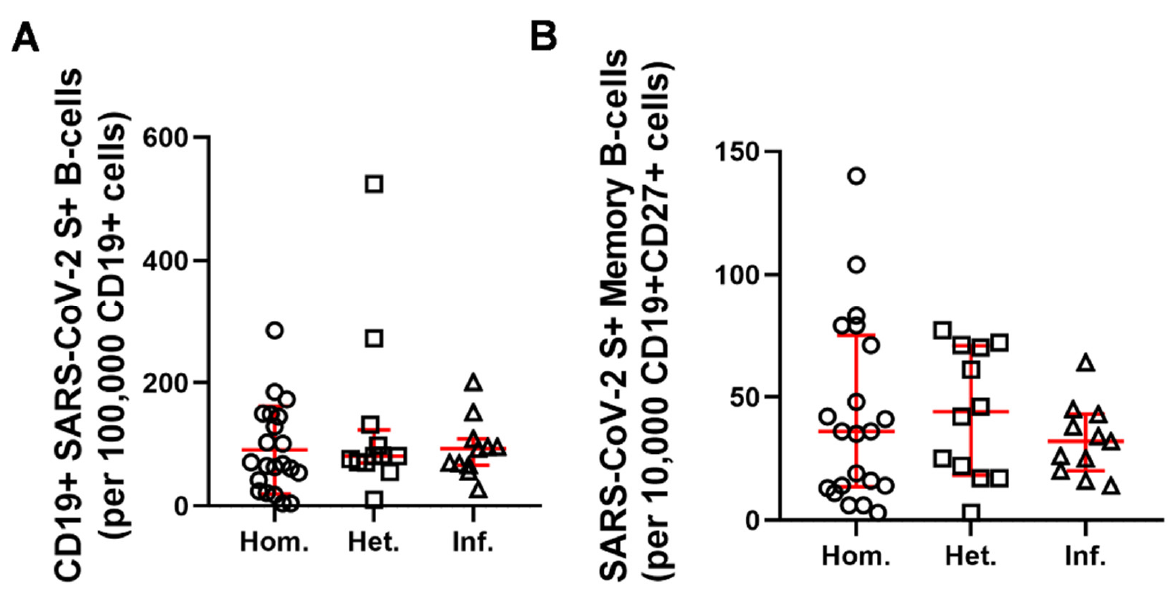
Figure 3. Quantitative analysis of peripheral SARS-CoV-2 S-protein reactive CD19+ B-cells ( A ) or CD19+CD27+ memory B-cells ( B ) of RMD patients. (circles: Hom. n = 21, squares: Het. n = 12, triangles: Inf. n = 11), Horizontal lines—median, whiskers—interquartile range. The IgM and isotype switched IgG, or IgA positive SARS-CoV-2 S protein